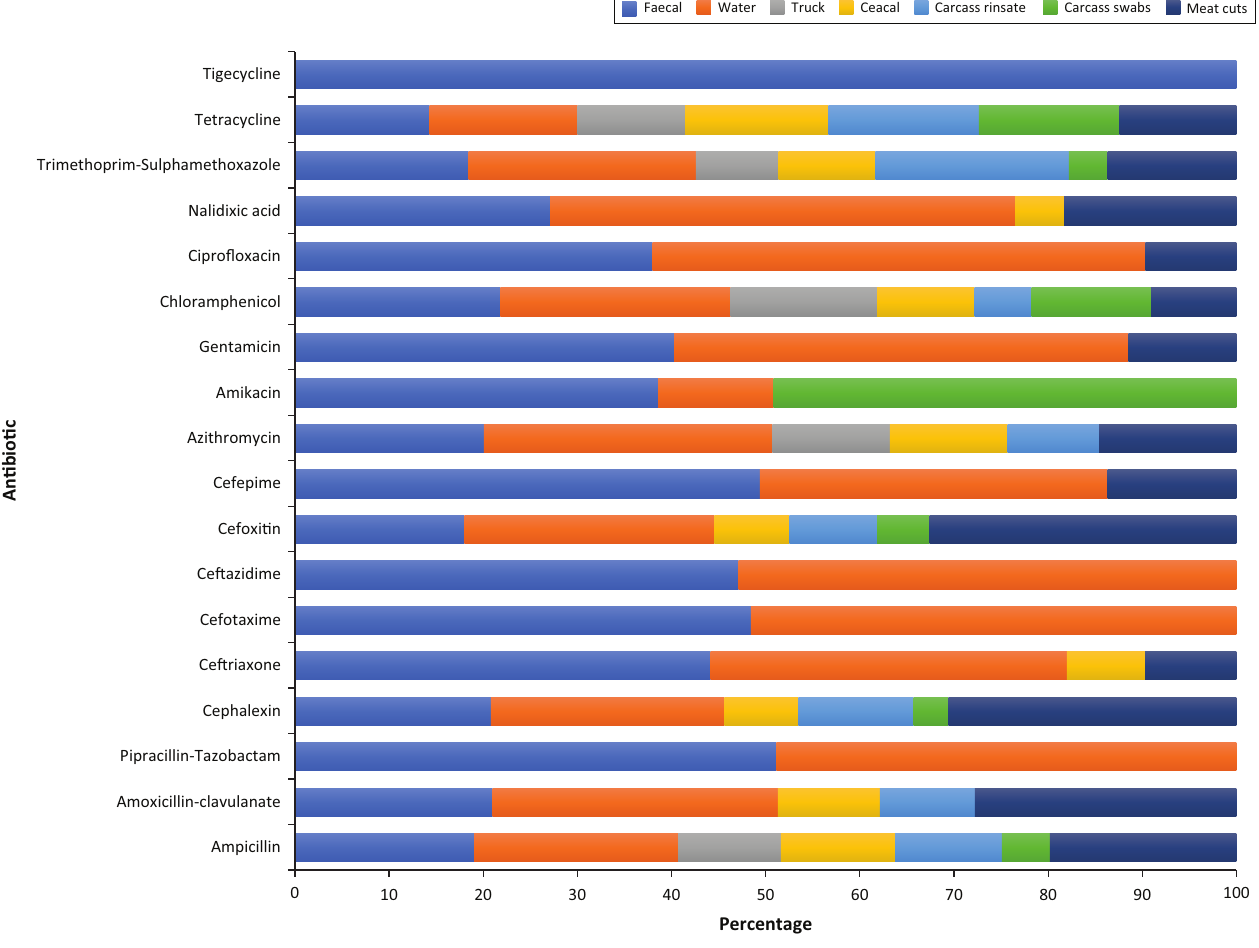
FIGURE 3: Percentage resistance to each antibiotic differed by